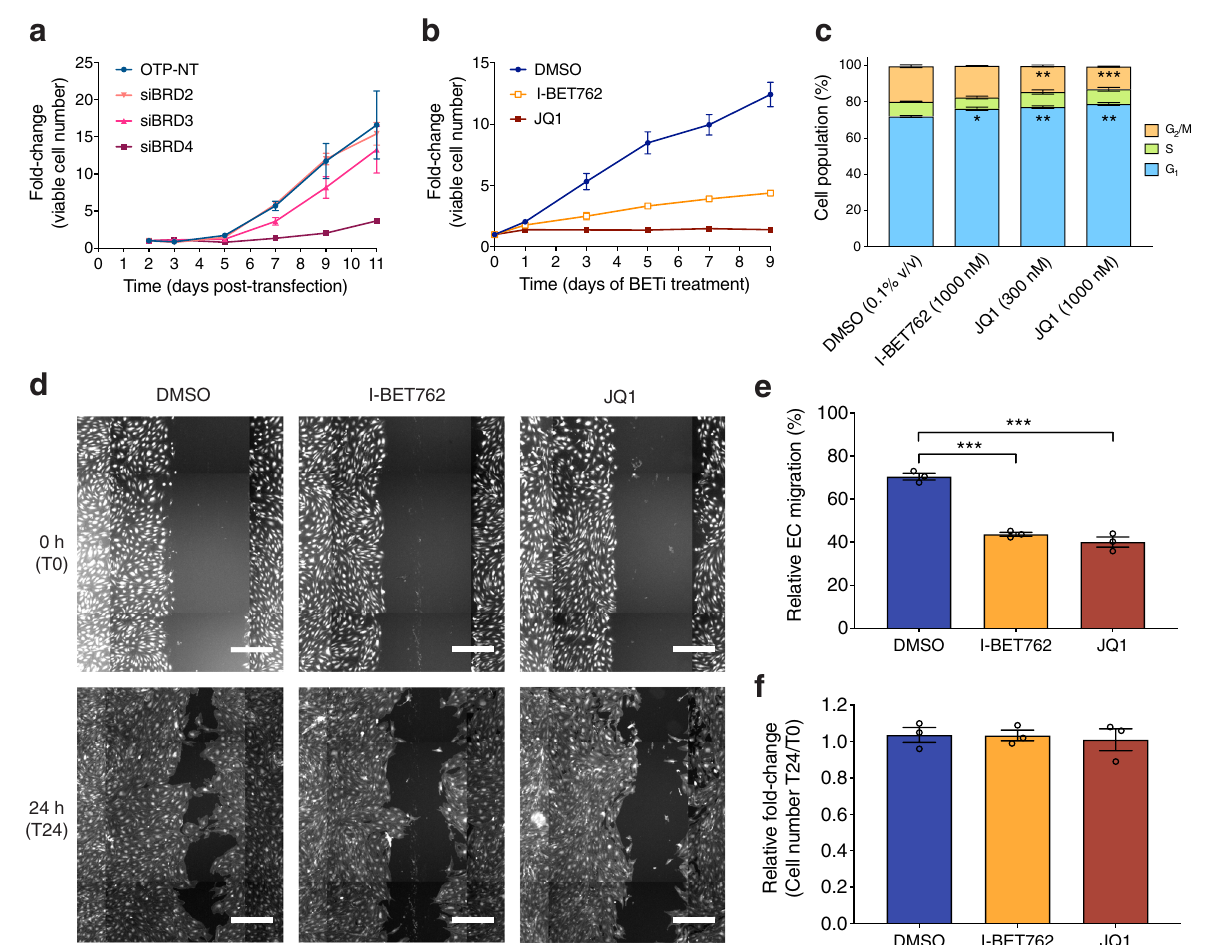
Fig. 4 Targeting BET protein suppresses key EC activities under normal growth conditions. a Effects of siRNA-mediated knockdown of BRD2 , BRD3, or BRD4 on survival and/or proliferation of ECs. Error bars represent ±SEM ( n = 2 independent experiments). b Effects of I-BET762 (1000nM) or JQ1 (300 nM) on survival and/or proliferation of ECs. Error bars represent ± SEM ( n = 2 independent experiments for all conditions except n = 4 independent experiments for DMSO). c Effects of BETi on nuclear DNA content of ECs. Nuclei were released and analyzed on day 3 of BETi treatment. Error bars represent ± SEM ( n = 2 independent experiments for all conditions except n = 3 independent experiments for DMSO). *, adjusted P value< 0.05; **, adjusted P value< 0.01; ***, adjusted P value< 0.001 (versus DMSO, one-way ANOVA with Dunnett ’ s multiple comparison test performed). d Scratch wound migration assay analysis of the effect of I-BET762 (1000nM) or JQ1 (300 nM) on EC migration. For imaging, ECs were stained using CellTracker Green CMFDA dye at 0 h (T0) then fi xed and stained with phalloidin CF488A and Hoechst 33342 at 24h after scratching (T24). Images were assembled as collages. Scale bars, 200 μ m. e Quanti fi cation of EC migration. f Quanti fi cation of cell number at T24 normalized to T0. Error bars represent ± SEM ( n = 3 independent experiments). *** P value< 0.001 (two-tailed unpaired t